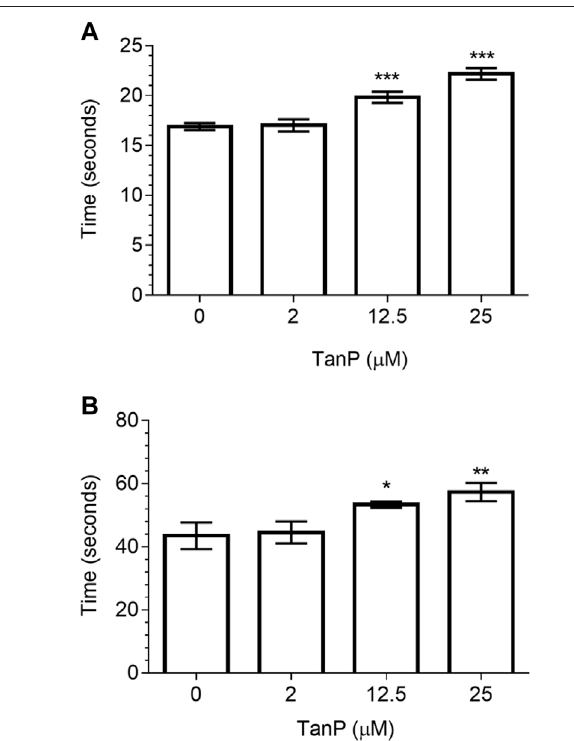
FIGURE 6 | Effect of TanP on pro-in fl ammatory cytokines levels in murine macrophage (RAW 264.7) supernatant. The release of cytokines (A) TNF- α and (B) IL-6 in the presence or absence ofLPS. The levels of cytokines secretion by cells were measured for 24 h after the interaction with LPS (2 μ g/ml) and/or at different concentrations of TanP (0 – 25 µM). Statistical signi fi cance was performed using ANOVA followed by Tukey ’ s test and expressed as mean ± SD (n (cid:2) 3). * p < 0.05 and *** p < 0.001, compared with the negative control group (cells without TanP or LPS) or the positive control group (cells only with